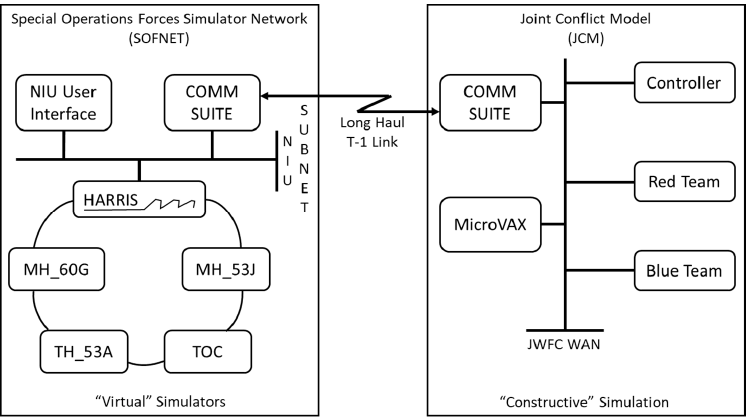
Figure 8. System architecture of SOFNET and JCM (Adapted from [37]).